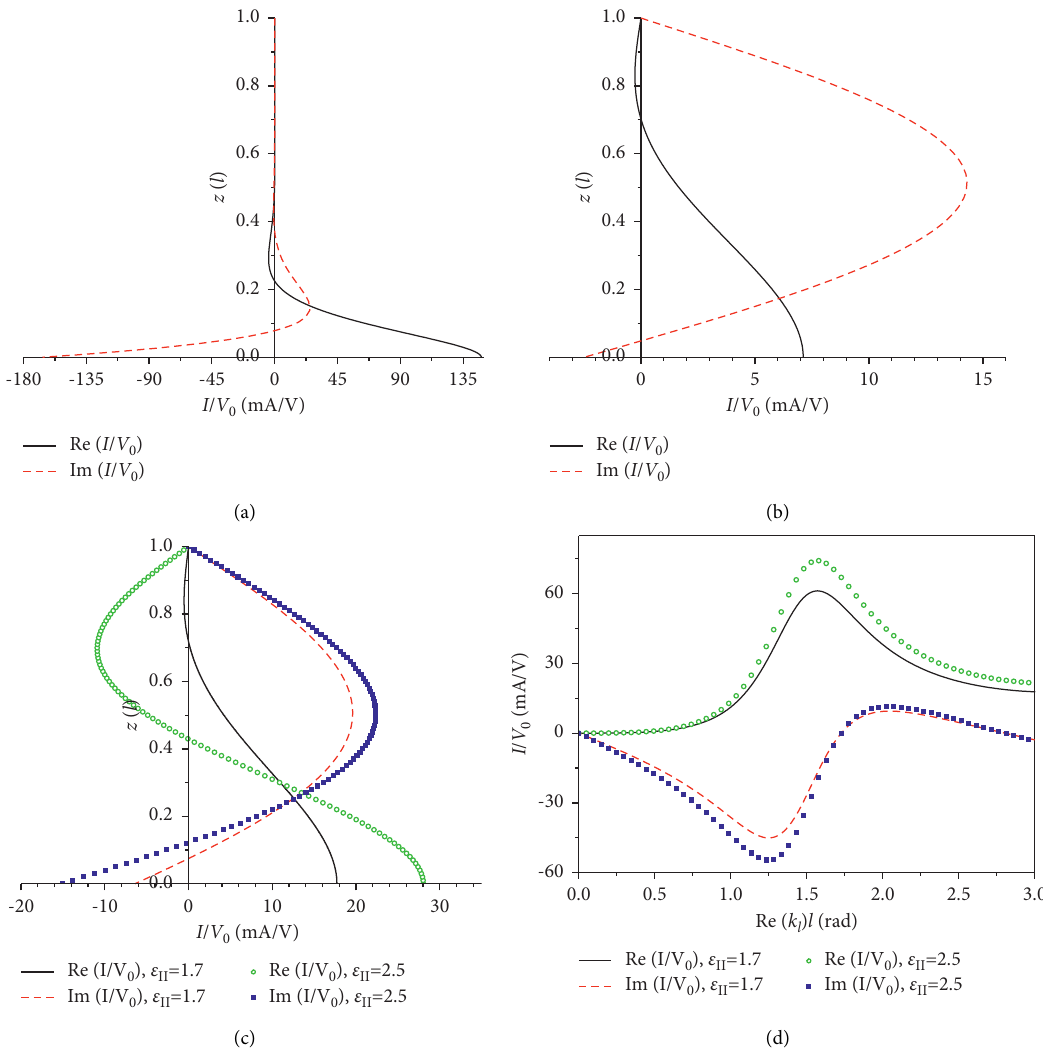
Figure 5: Real and imaginary parts of normalized current on an insulated antenna in an anisotropic ionosphere. (a) b / a � 1.01, Re ( k l � 10.75, (b) b / a � 2.0, Re( k l ) l � 3.25, (c) b / a � 1.5 versus z / l , and (d) b / a � 1.5 versus Re ( k l ) l